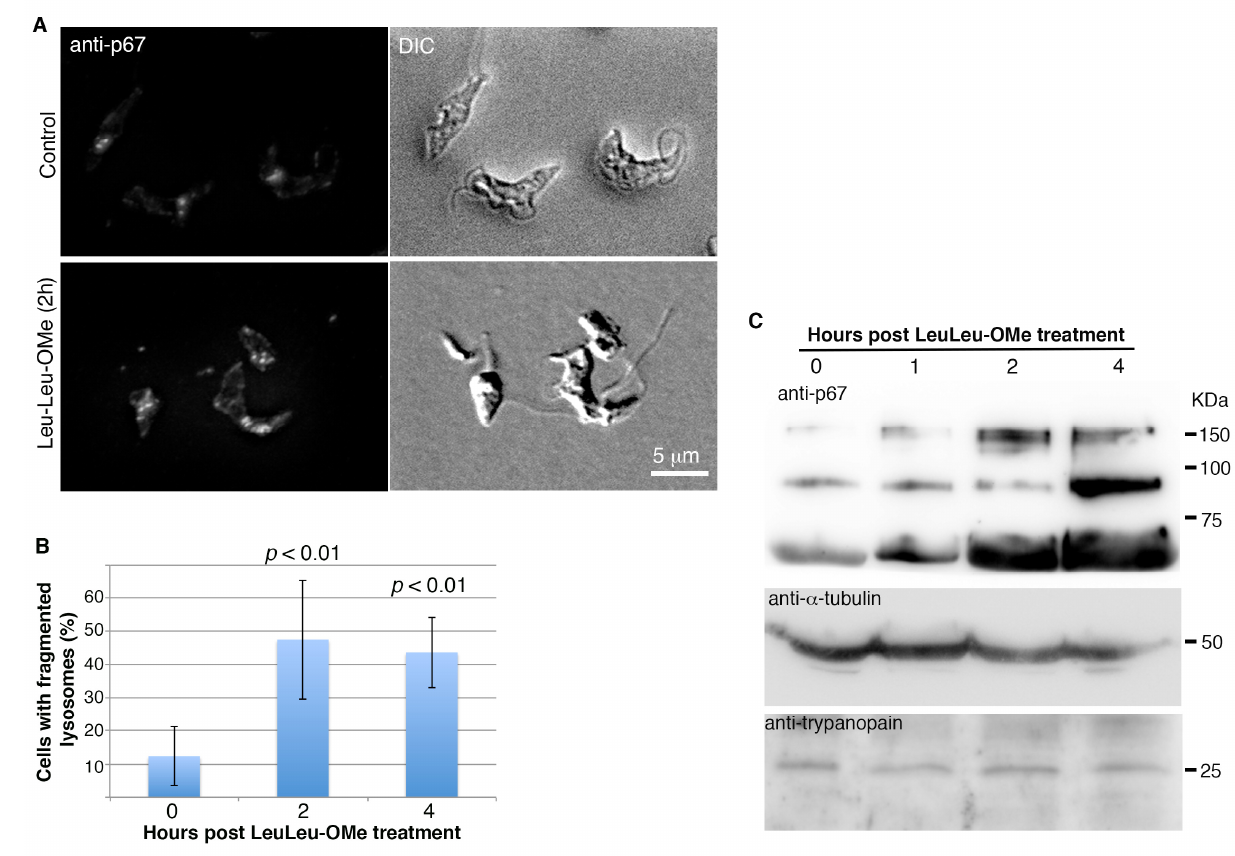
FIGURE 2: Lysosome destabilizing effects of LeuLeu-OMe. (A) T. brucei cells were incubated with or without 30 µM LeuLeu-OMe, and sam- ples were taken at t = 0 h, 1 h, 2 h and 4 h for immunofluorescence assays with anti-p67. Representative images of control and LeuLeu- OMe-treated cells are maximum intensity projection of serial optical sections through the entire cells. (B) Quantitation of images as shown in (A) revealed an increase in lysosome fragmentation at 2 h and 4 h post Leuleu-OMe treatment. The quantitation results are presented as mean ± SD from 3 independent experiments. (C) Samples treated as described in (A) were also processed for immunoblotting analyses with anti-p67 and anti-trypanopain. Anti-α-tubulin was used as a loading